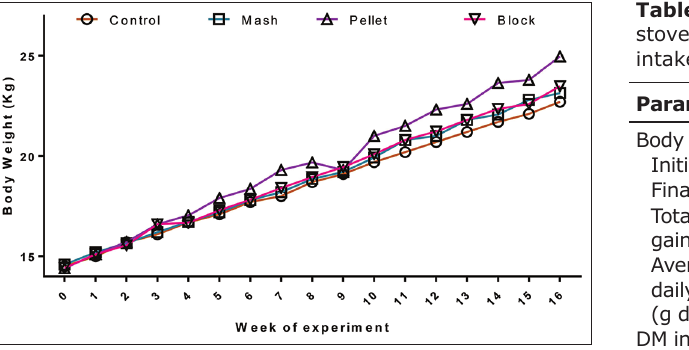
Figure-1: Body weights (kg) of the lambs-fed chopped, mash, pellet, and block form of rations during the growth trial.